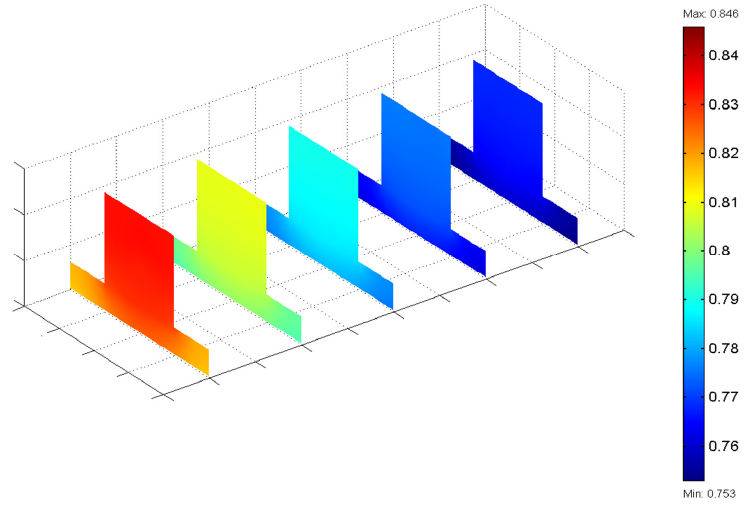
Figure 12. Variation of hydrogen molar fraction within the anode at peak